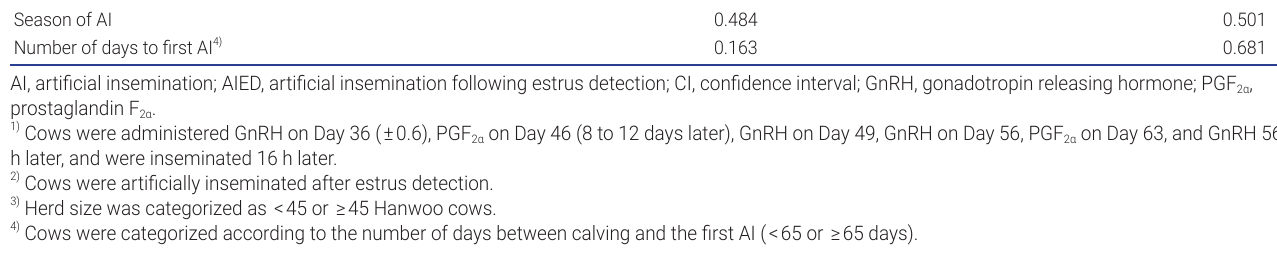
Table 2. Factors affecting the overall pregnancy per AI 60 on days after the second or later AI in Hanwoo cows